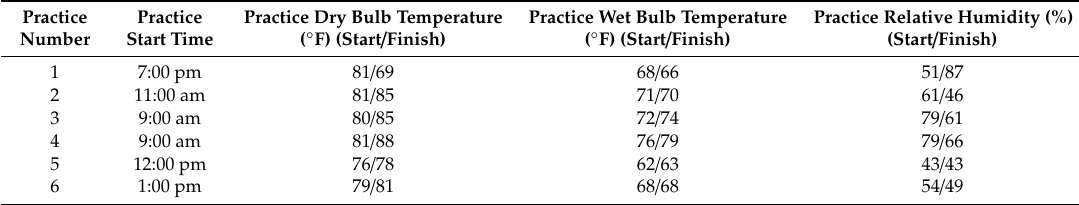
Table 2. Practice